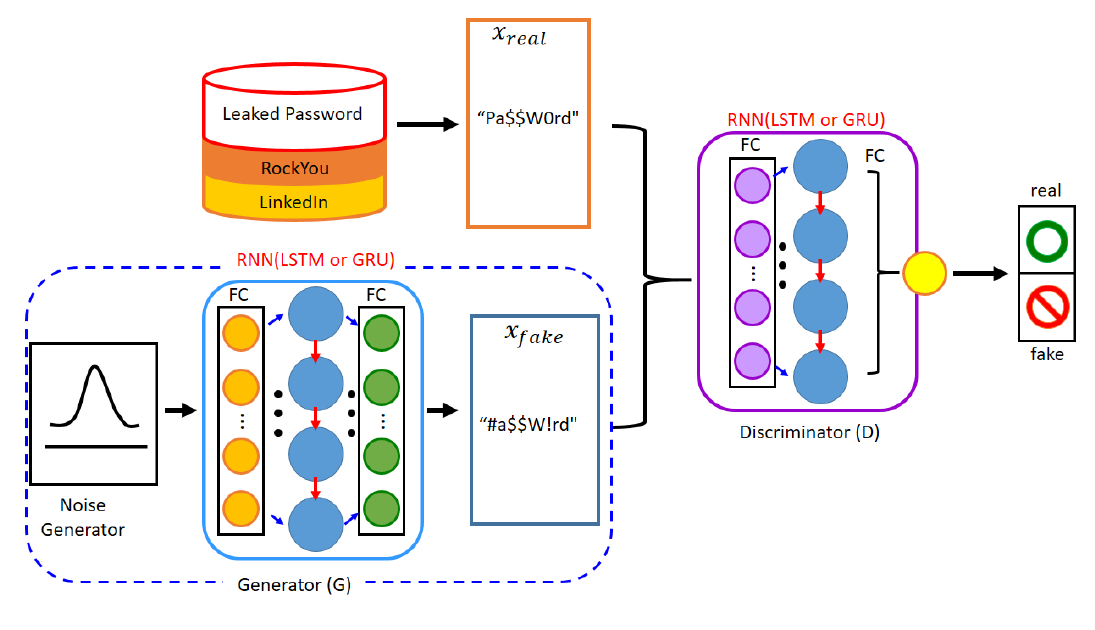
Figure 1. The model architecture of PassGAN & rPassGAN: PassGAN’s G and D consist of a five-layered residual convolutional neural network (CNN) with filter size 5. Otherwise, we replace the five-layered residual CNN with a one-layer RNN. In the rPassGAN, the red arrow stands for the recurrent flow. We mainly use gated recurrent unit (GRU) cells, because the training and sampling speed is better than long short-term memory (LSTM). FC stands for the fully-connected multilayer perceptron (MLP) in both Figure 1a,b. GAN stands for generative adversarial